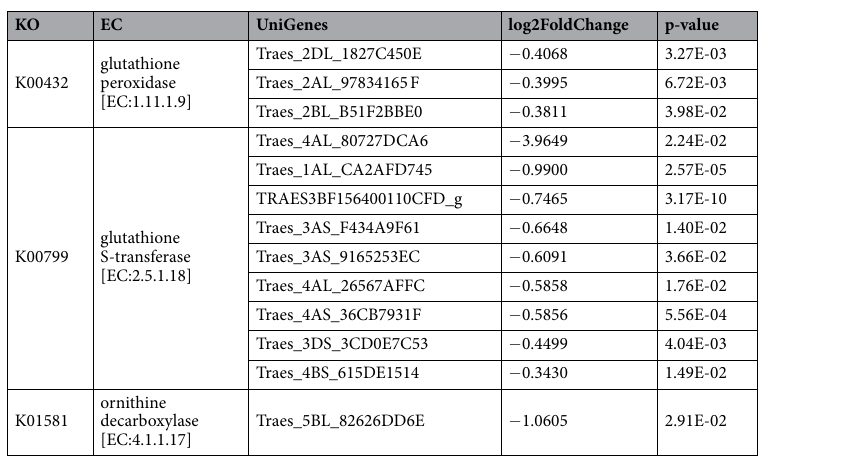
Table 2. List of DEGs enriched in glutathione metabolism